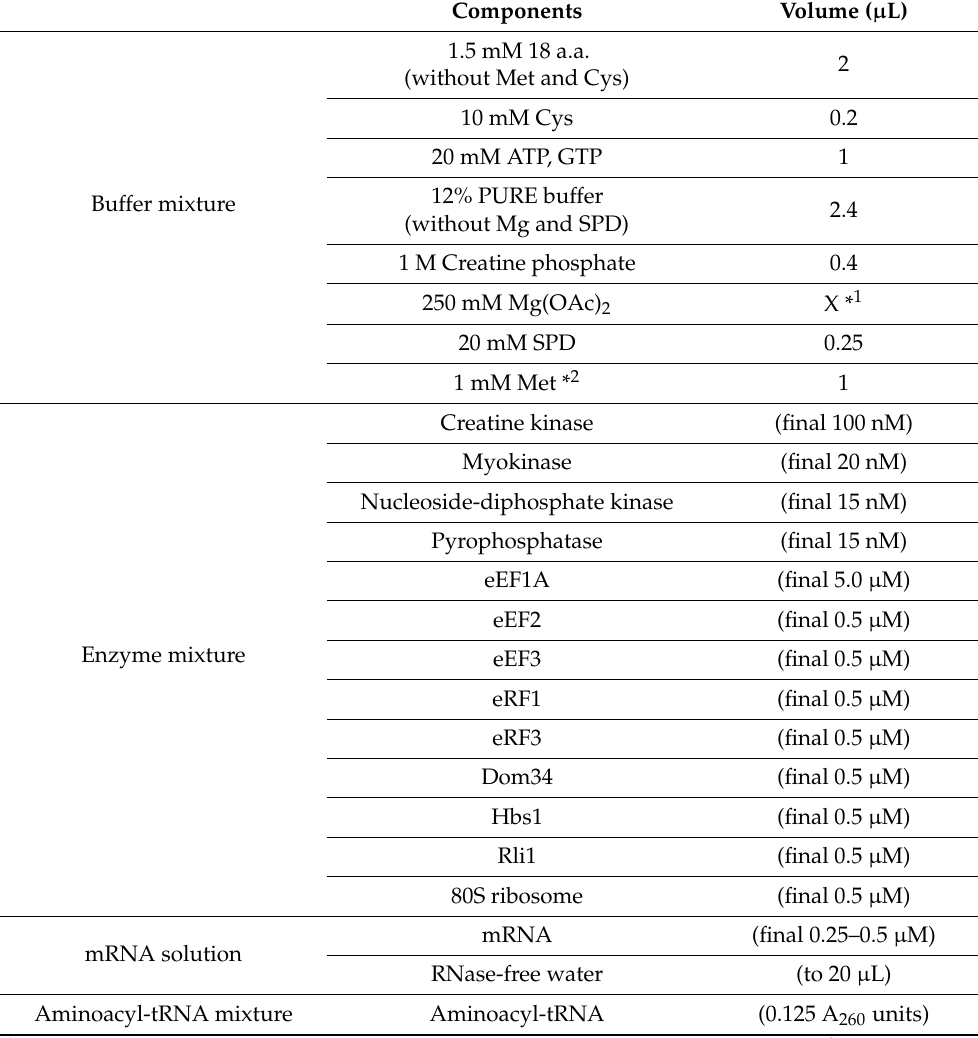
Table 4. Components in the “Translation Reaction without Coupled